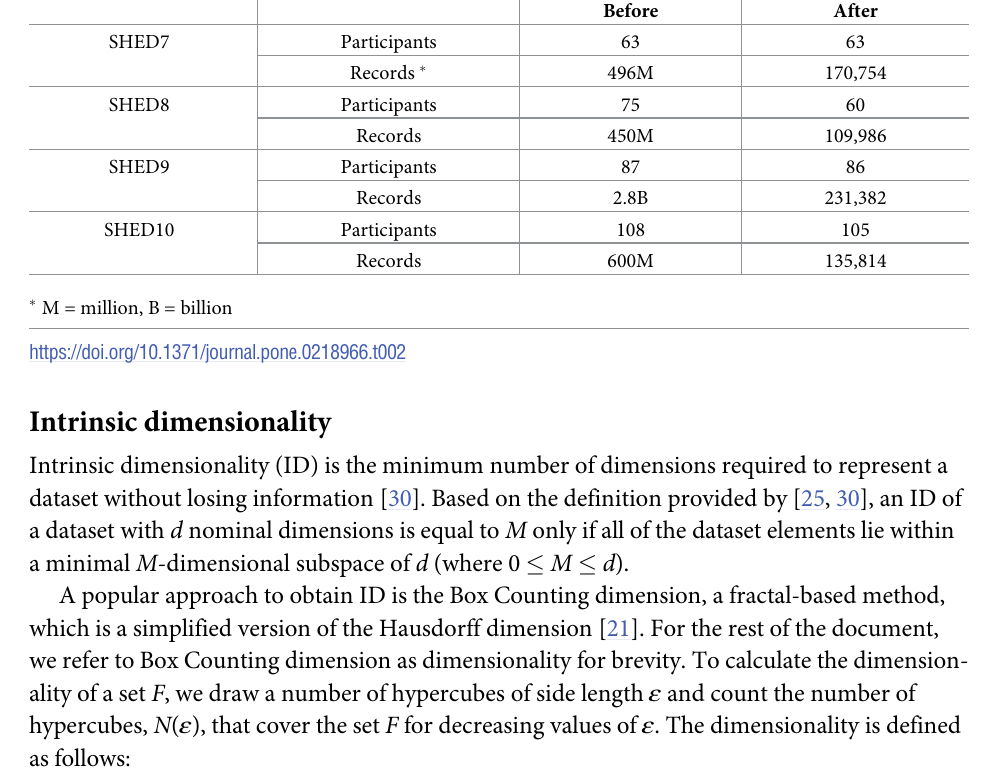
Algorithm 1 Dimensionality implementation